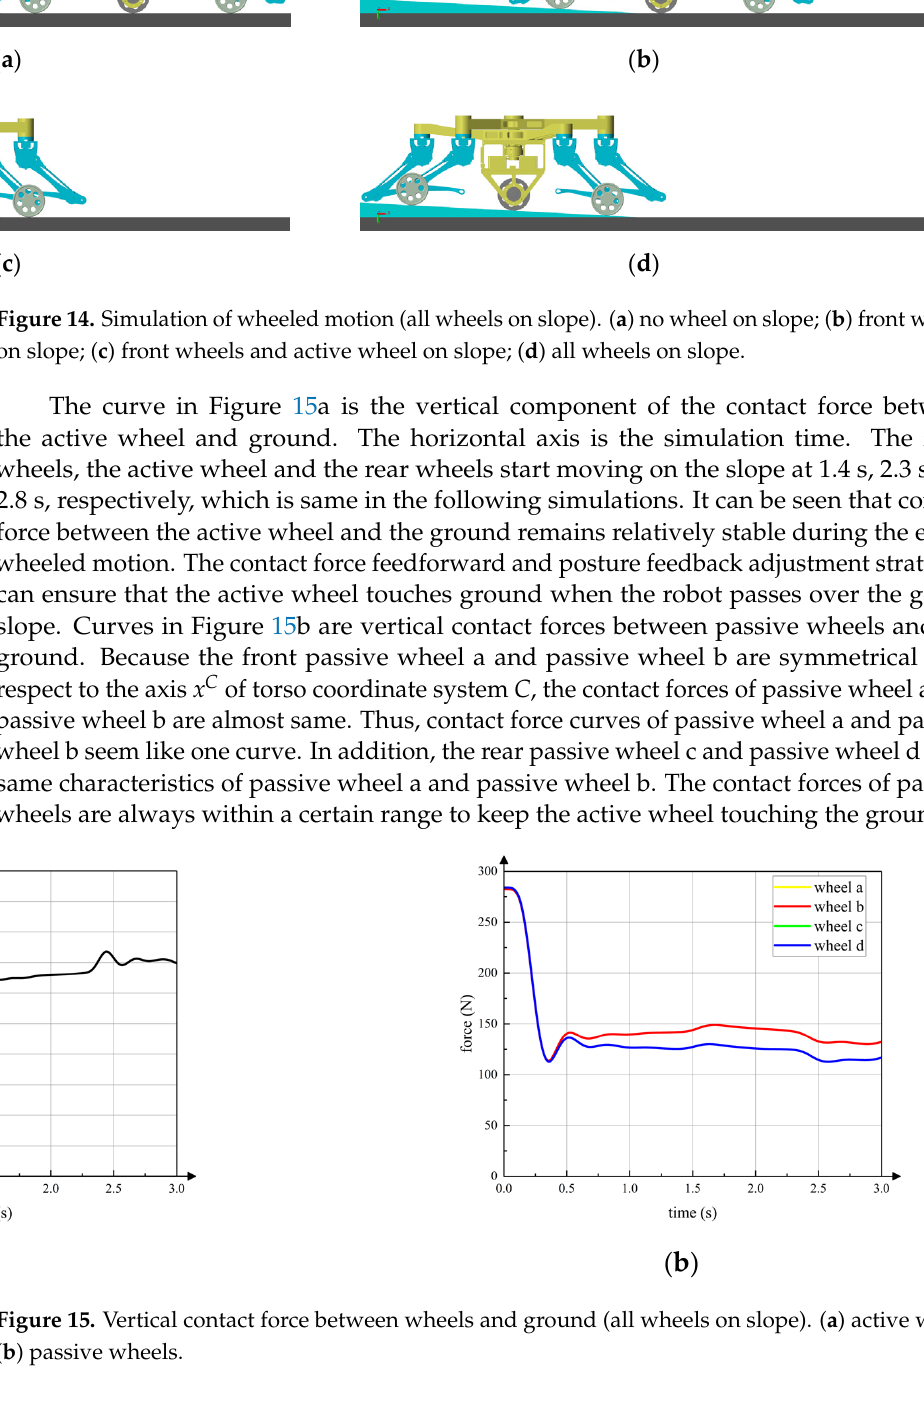
( d ) Figure 16. Simulation of wheeled motion (unilateral passive wheels on slope). ( a ) no wheel on slope; ( b ) front wheel on slope; ( c ) front wheel on slope and active wheel on flat ground; ( d ) two wheels on slope.